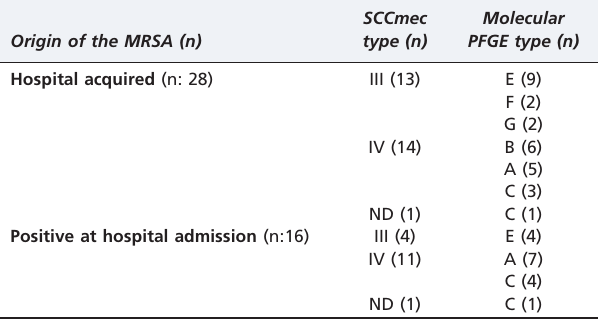
Table 2 - SCC mec type and molecular type of 67 MRSA isolates according to the origin of acquisition.